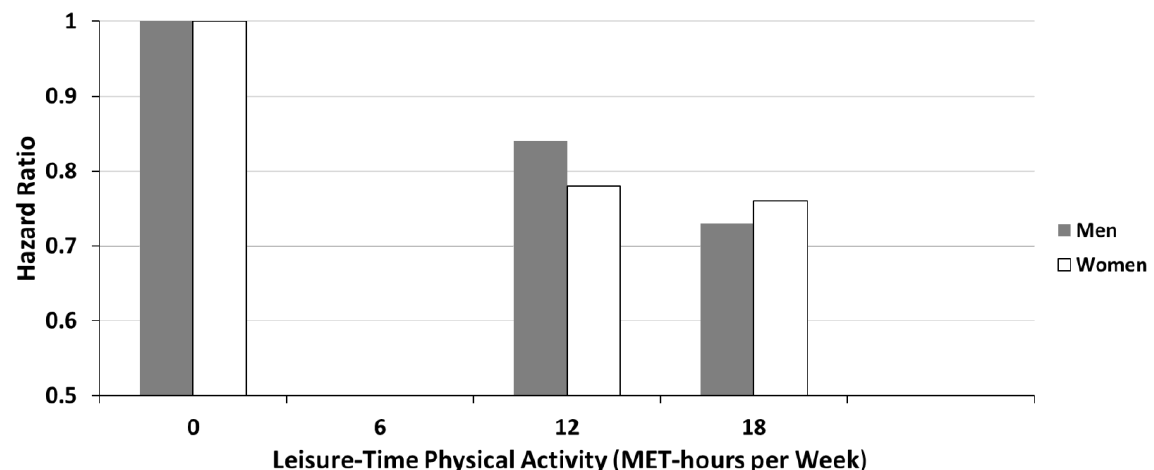
Figure F10-5. The Inverse Relationship Between Cardiovascular Mortality and Leisure-time Physical Activity by MET-hours per Week Among Adults with